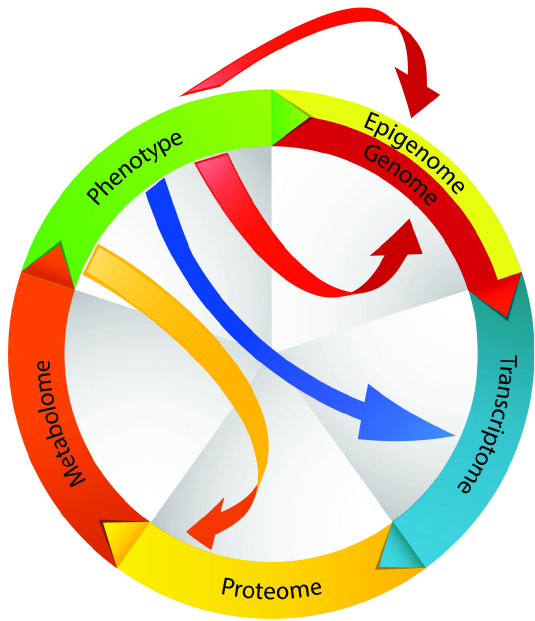
Figure 4. CRC is derived from an accumulation of genomic and epigenomic alterations. Alterations at the transcriptional level also occur due to the influence of regulatory RNAs (e.g., long noncoding RNA, miRNA, pseudogenes). Post-translational regulation and post-translational modifications further contribute to functional perturbations in tumor cells. These sequential and synchronous events contribute to the phenotype. Phenotype can further modify the genotype as well as any of the downstream events. According to this model, the metabolome represents the closest molecular representation of